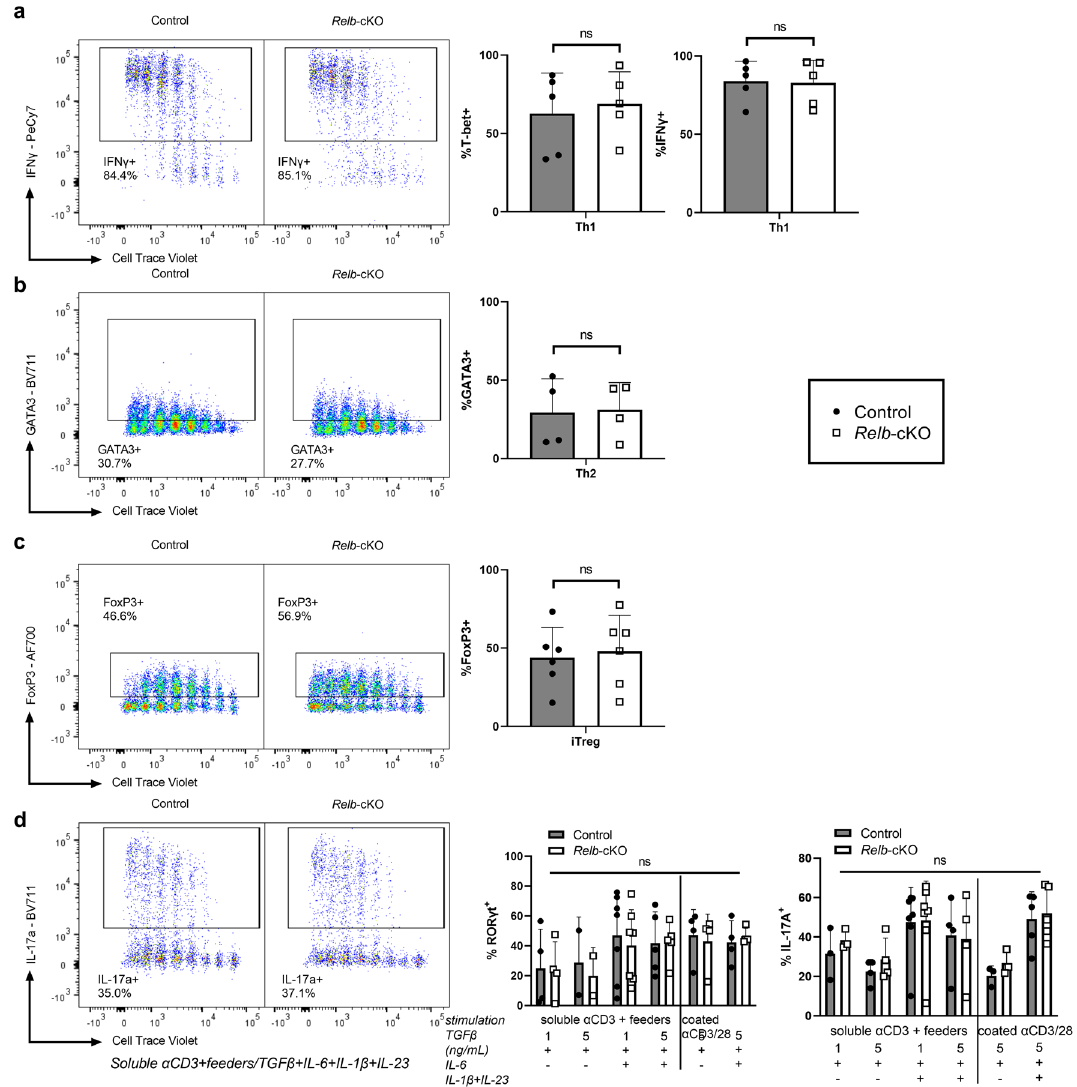
Figure 3. Thelper polarization profile is maintained in the absence of RelB. CTV-labeled naïve Tconv cells were stimulated in TH1, TH2, iTreg-polarizing conditions ( a-c ) or with different TH17 stimulation protocols ( d ) as described in the Methods section . After 4 days of culture, cells were restimulated with PMA/ionomycin and analyzed by flow cytometry. ( a ) Percentage of T-bet + and IFNγ + cells in the TH1 condition, ( b ) GATA3 + cells in the TH2 condition, and ( c ) Foxp3 + cells in the iTreg condition. ( d ) Percentage of RORγt + and IL-17a + cells in various TH17 conditions. ns :